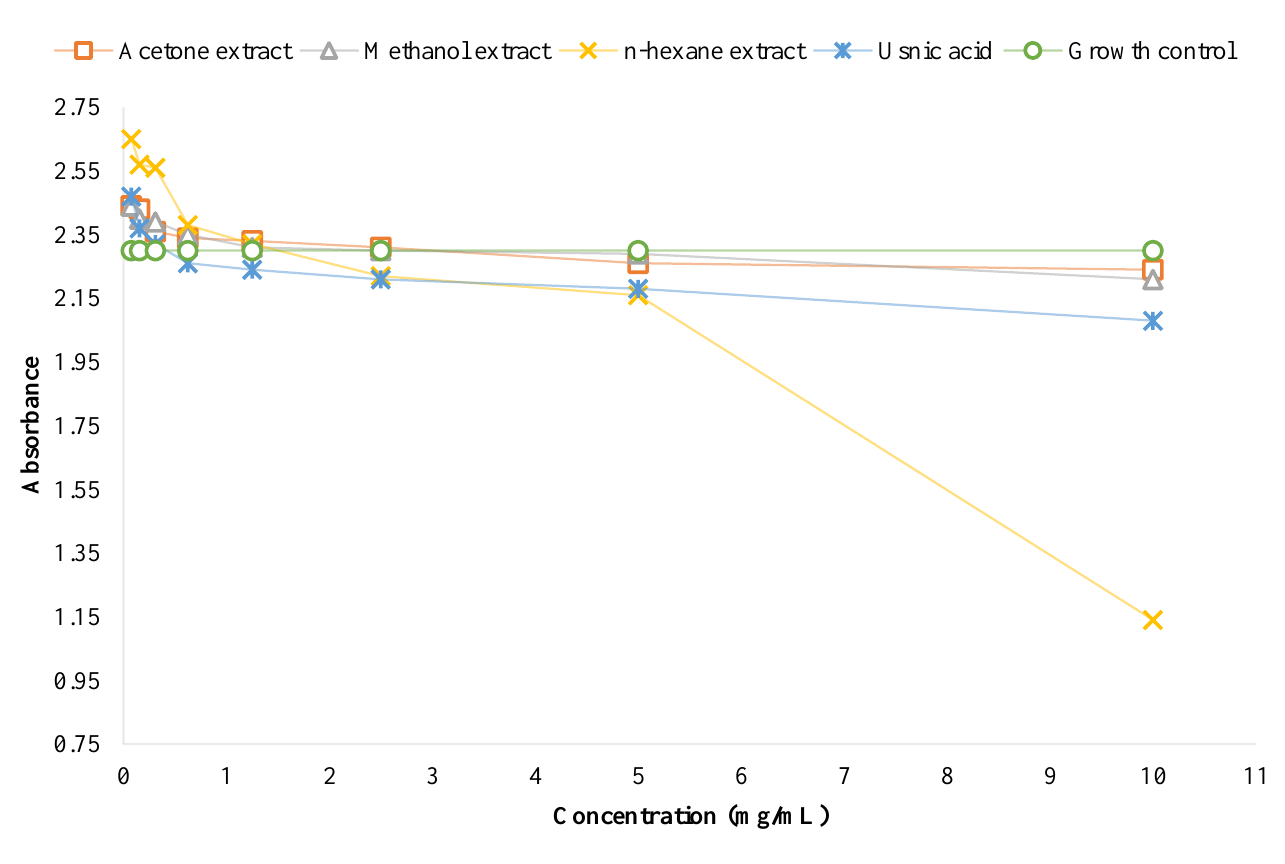
Figure 4. The impact of the tested extracts and usnic acid on the metabolic activity of S. aureus ATCC 6538 biofilm.